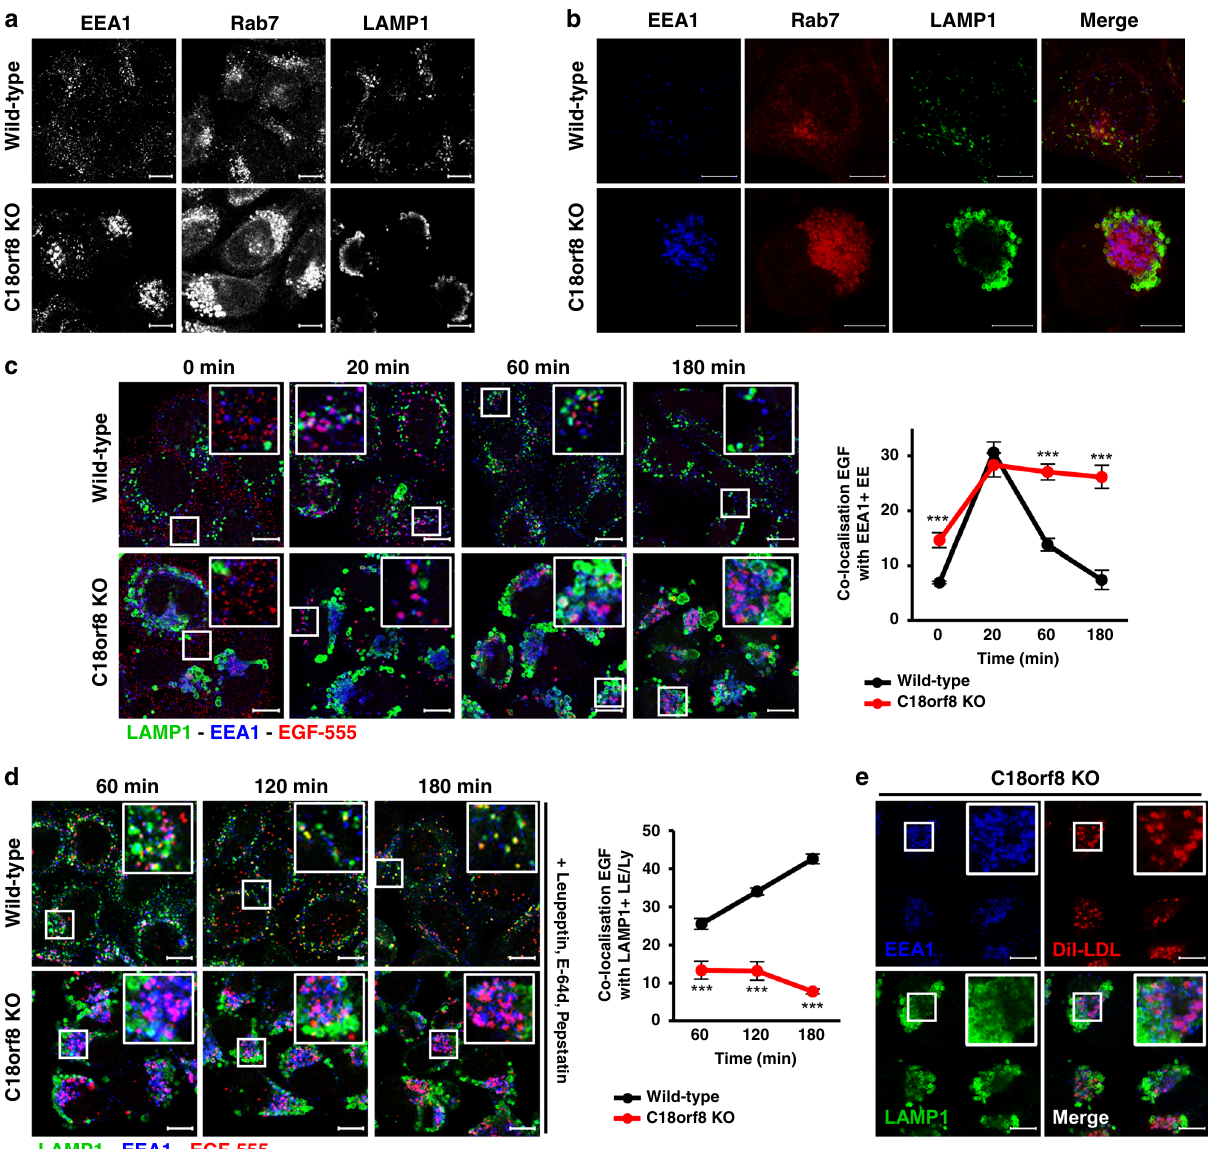
Fig. 4 C18orf8 -de fi cient cells show severe defects in late endosome morphology and early-to-late endosomal traf fi cking. a , b C18orf8 -de fi cient cells show clustering of EE and swelling of LE/Ly. Confocal microscopy comparing EEA1, Rab7 and LAMP1 single ( a ) or co-staining ( b ) in wild-type versus C18orf8 -de fi cient cells. Representative images are shown from fi ve fi elds per condition and 2 independent experiments. c – e C18orf8 -de fi cient cells have severe defects in early-to-late endosomal traf fi cking. c , d Wild-type and C18orf8 -de fi cient cells were starved for 1 h, pulse-labelled with AlexaFluor555- conjugated EGF (red), incubated for the indicated times, fi xed and stained for EEA1 (blue) and LAMP1 (green). In d a cocktail of protease inhibitors (Leupeptin/E-64d/Pepstatin) was added during starve and chase to block EGF degradation. EEA1 + and LAMP1 + vesicles were identi fi ed using Volocity software and the percentage of EGF co-localising with these structures was determined from n = 5 fi elds per condition with at least eight cells per fi eld. Error bars re fl ect standard error of mean (two-sided unpaired t -test, *** p < 0.001). e C18orf8 -de fi cient cells were stimulated with Dil-LDL (red), chased for 3 h, fi xed and stained for EEA1 (blue) and LAMP1 (green). Representative images are shown from fi ve fi elds. Scale bars = 10 µ C18orf8 is an integral component of the Mon1-Ccz1 complex . locus, yielding an endogenous C18orf8-3xMyc fusion (Supple- To further characterise C18orf8 function, we identi fi ed C18orf8- mentary Fig. 5a, b). Pull-down of C18orf8-3xMyc precipitated interacting proteins by mass spectrometry. Pull-down of N- or C- Ccz1 and Mon1B (Fig. 5c), and conversely, immune precipitation terminal HA-tagged C18orf8 from HeLa cells revealed a domi- of endogenous Mon1B (Fig. 5c) or Ccz1 (Supplementary Fig. 5c) nant interaction with three proteins – Ccz1, Mon1A and Mon1B revealed the endogenous 3xMyc-tagged C18orf8. C18orf8 is – the three components of the mammalian MC1 complex (Fig. 5a composed of an N-terminal WD40 and C-terminal α -helical and Supplementary Data 2, PXD021444). The interaction domain. To identify the MC1-interaction site in C18orf8, we between overexpressed C18orf8 and endogenous Ccz1 and expressed mScarlet-tagged single domains (Supplementary Mon1B was readily con fi rmed by immunoblot (Fig. 5b). To Fig. 5d). Immune precipitation revealed an interaction of Ccz1 visualise the interaction between endogenous proteins, we used and Mon1B with the C-terminal (AA 354-657), but not N- CRISPR technology to knock-in a 3xMyc-tag into the C18orf8 terminal (AA 1-362) domain of C18orf8 (Supplementary Fig. 5e).